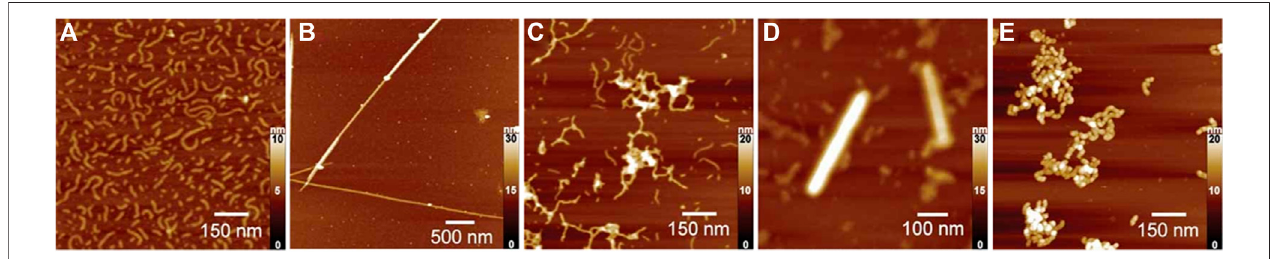
FIGURE 18 | Cylindrical brush-nanorod-network switching in an electrostatically self-assembled polymer-brush porphyrin system; AFM: (A) wormlike PVP brushes, pH 7; (B) porphyrin nanorods, pH 2; (C) porphyrin-brush networks, pH 7; (D) nanorod-brush system, set from pH 7 to pH 2; (E) switched networks, pH 7; (F) nanorod-brush system, prepared at pH 2 (Ruthard et al., 2011b). Reprinted with permission. Copyright © 2011 WILEY-VCH Verlag GmbH and Co. KGaA,